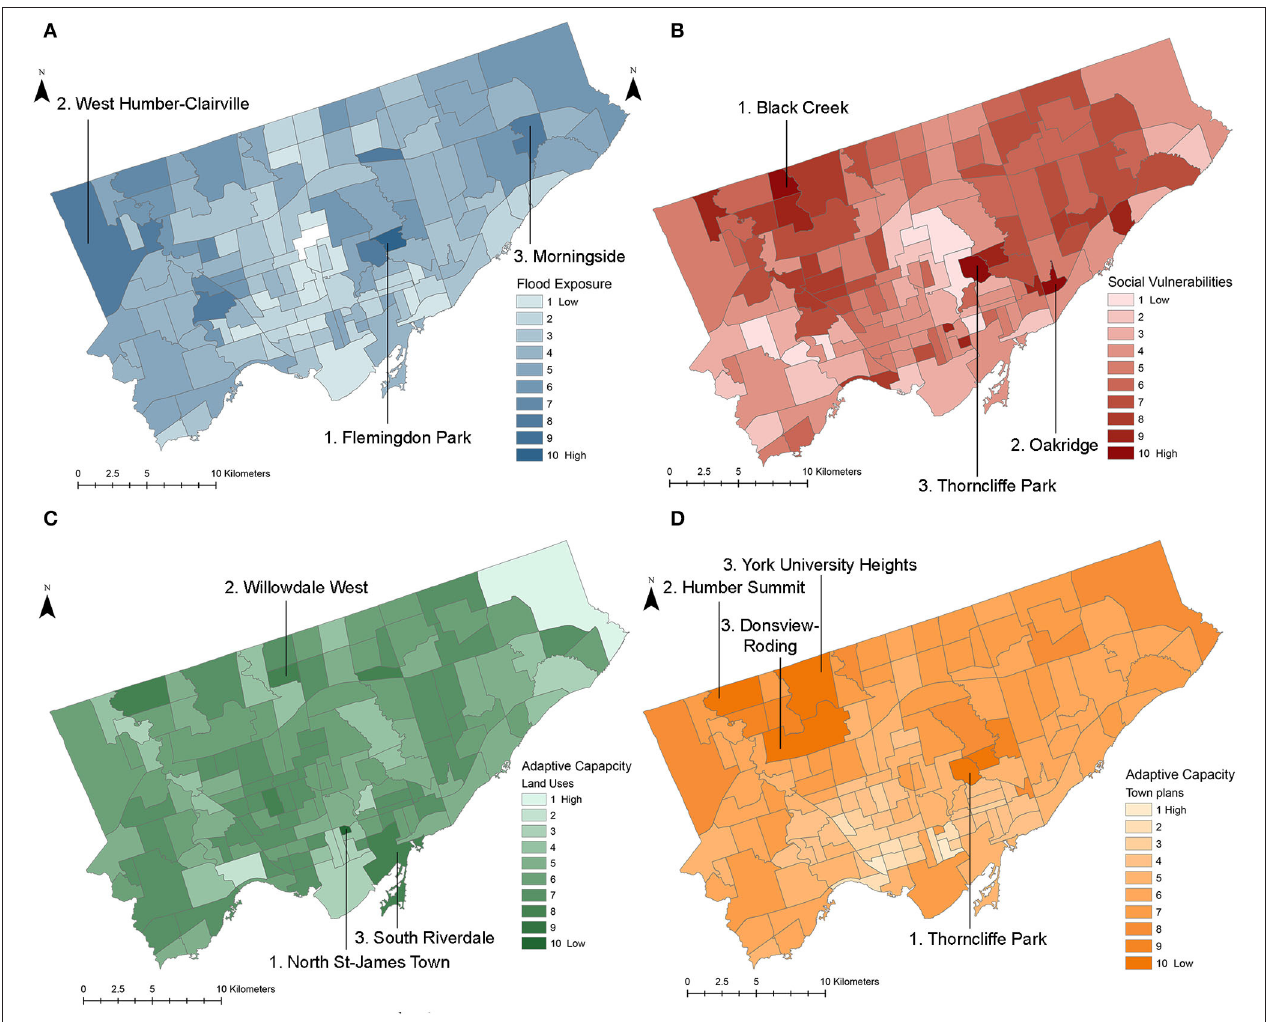
FIGURE 5 | The spatial distribution of the four risk drivers. (A) The spatial distribution of flood hazard exposures across the neighborhoods. (B) The spatial distribution of social vulnerabilities across the neighborhoods. (C) The spatial distribution of neighborhoods with a low adaptive capacity of land uses. (D) The spatial distribution of neighborhoods with a low adaptive capacity of town